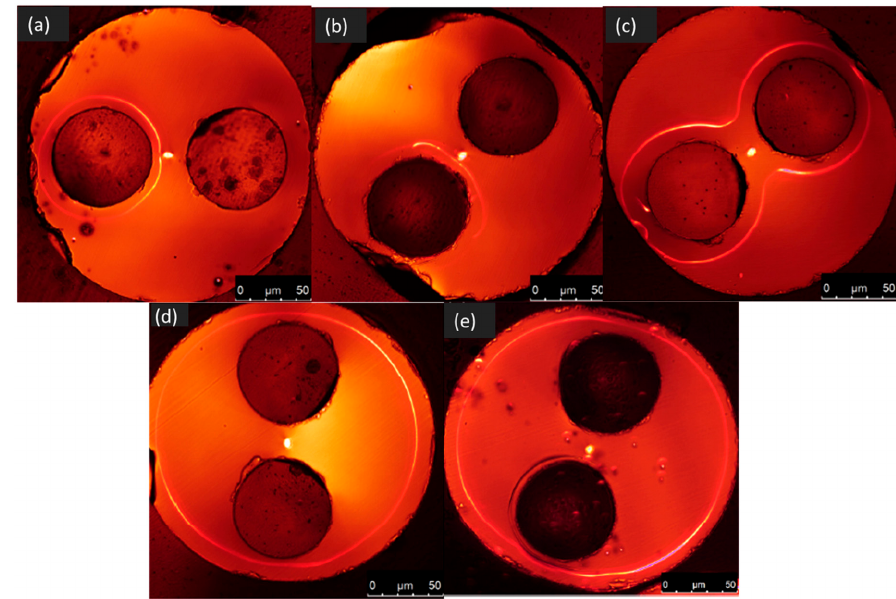
Figure 1. Second harmonic (SH) micrographs of twin-hole silica fibers poled in di ff erent electrical configurations, namely ( a ) conventional anode–cathode, ( b ) single anode, ( c ) anode–anode, ( d ) single cathode and ( e ) cathode–cathode. The figures are extracted from the work of An et al.